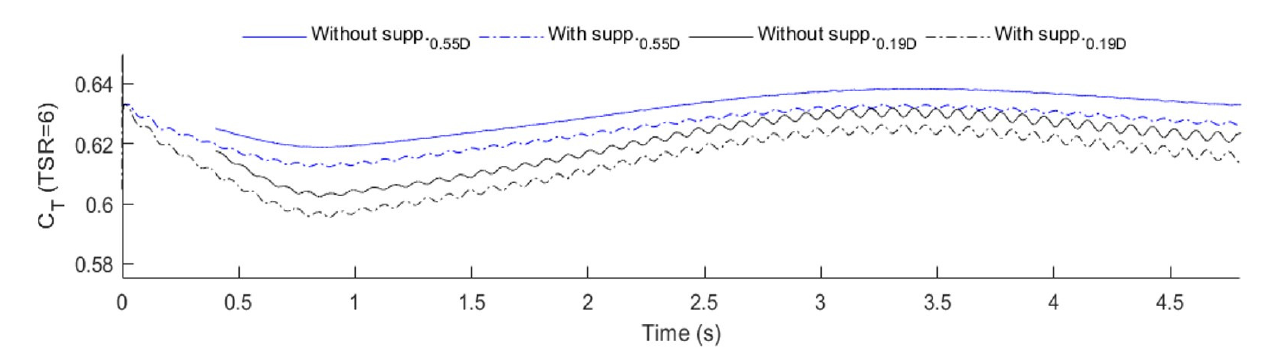
Figure 6. Time history of power coefficient for deep and shallow tip immersions, with and without support structure. Results are for λ = 6.